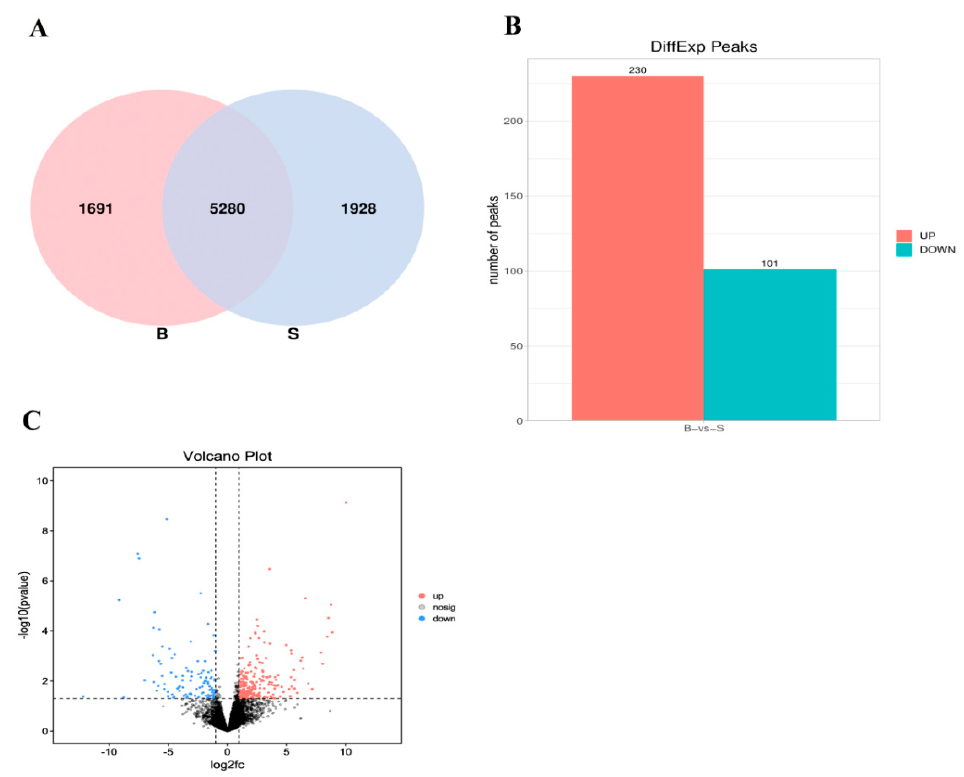
Figure 3. Peak analysis of difference between groups; ( A ) Common and unique peak of adipose and muscle tissue; ( B ) Difference peak histogram; ( C ) Analysis of peak related genes between adipose and muscle tissue. (‘B’ refers to the longest dorsal muscle and ‘S’ refers to perirenal fat).